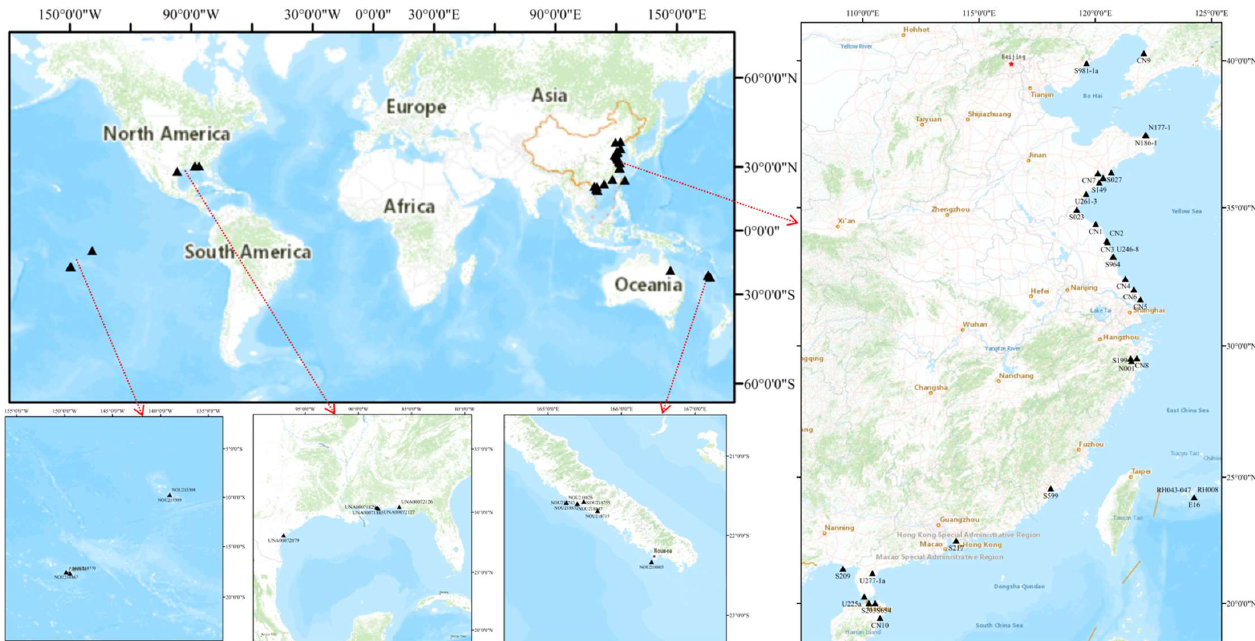
Figure 6. Global distribution of U. meridionalis. See Table 1 for details on the sampling